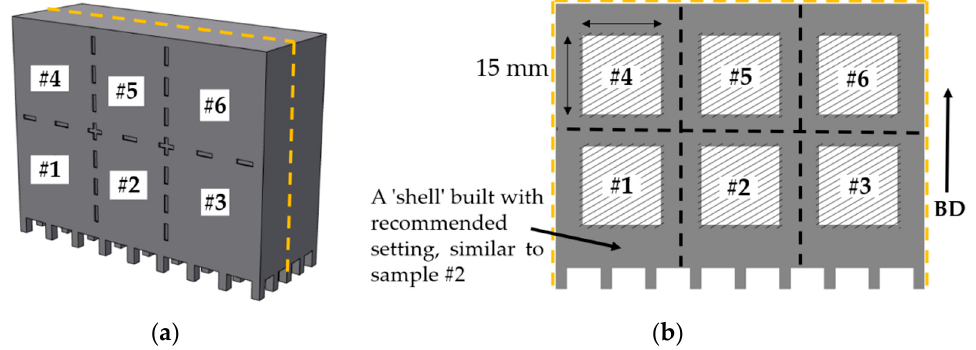
Figure 1. Schematic of the CAD model of one of multiple identical blocks comprising the electron beam melting (EBM) build ( a ), and cross-section view of the block revealing the cubes (marked by hatched lines) processed with different line spacing ( b ). The arrow on the right shows the build direction, BD. Table 1. EBM process parameters.